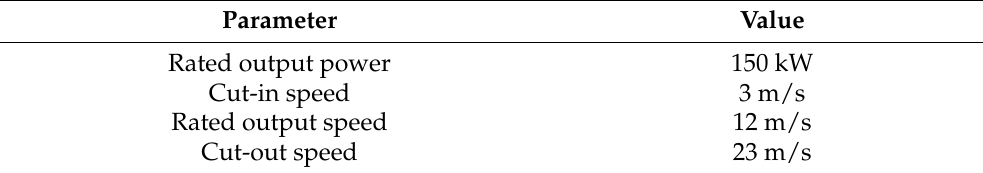
Figure 3. Actual and short-term forecast for wind speed. Table 1. Wind turbine